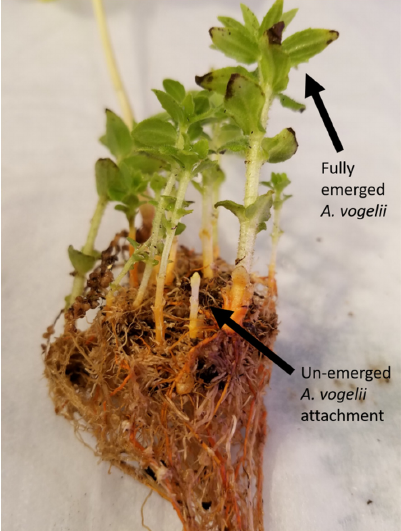
Figure 1. Alectra vogelii parasitism of susceptible cowpea line 524B eight weeks after planting. Shown is the growth of the parasite that occurs following successful attachment and development. The soil has been removed to allow visualization of un-emerged parasites.